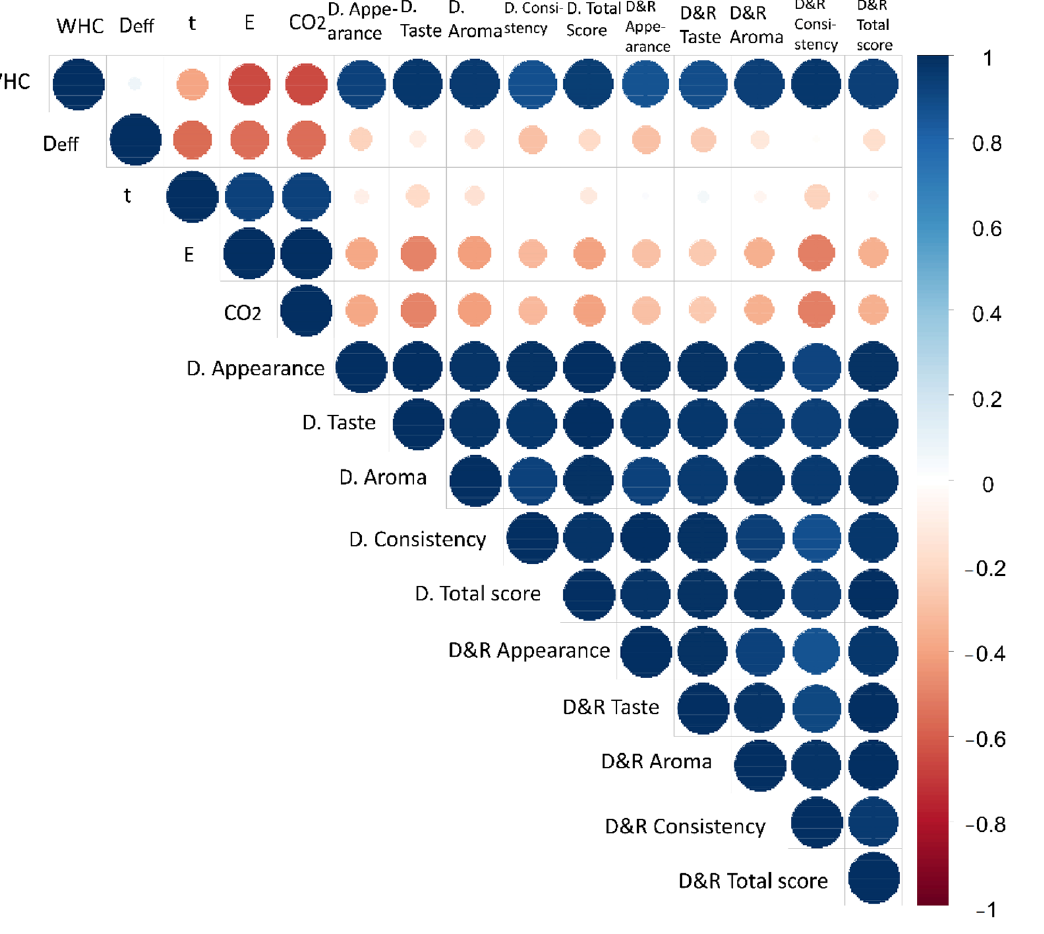
Figure 5. Color correlation diagram between the parameters of the independent variables and the responses of dehydration method.